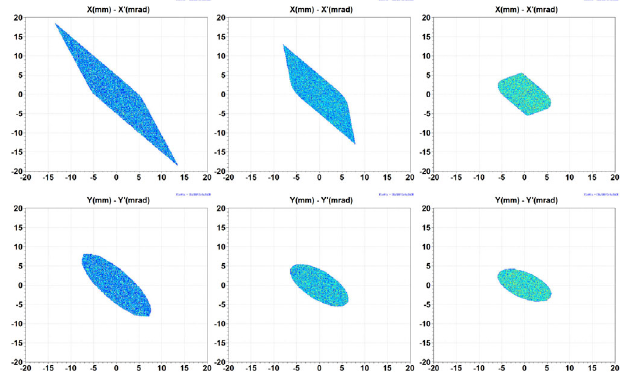
FIG. 9. Acceptance of VDS for different energies. To avoid too large position or angle in phase space, the acceptance calculation includes part of the matching section between the collimation and the VDS, i.e., from the end of the last quadrupole Q 5 of the matching section until the end of VDS. (From left to right: beam energy E ¼ 500 , 1000, 1500 MeV; the top is for X-X ’ and the bottom is for Y-Y ’ )